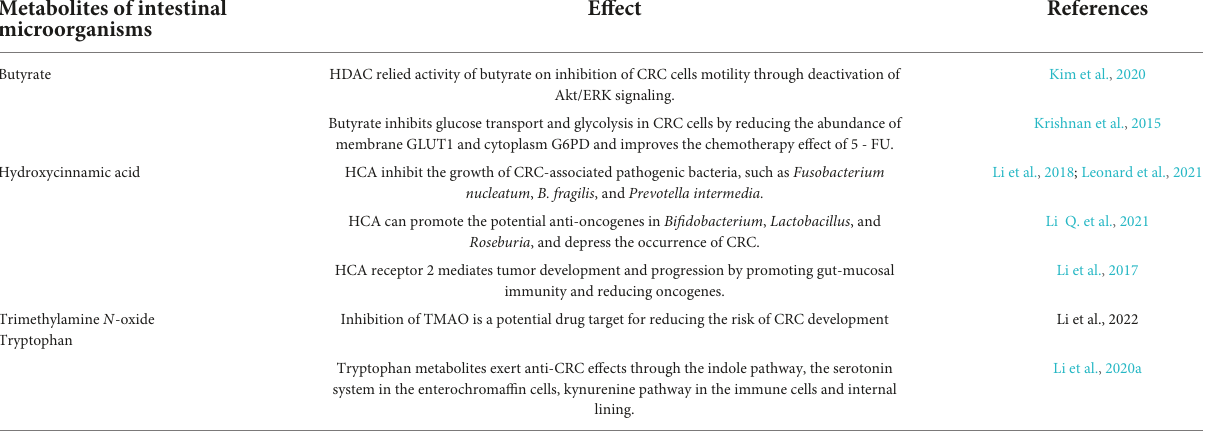
TABLE 2 The chart summarizes how metabolites of intestinal microorganisms affect CRC. Metabolites of intestinal